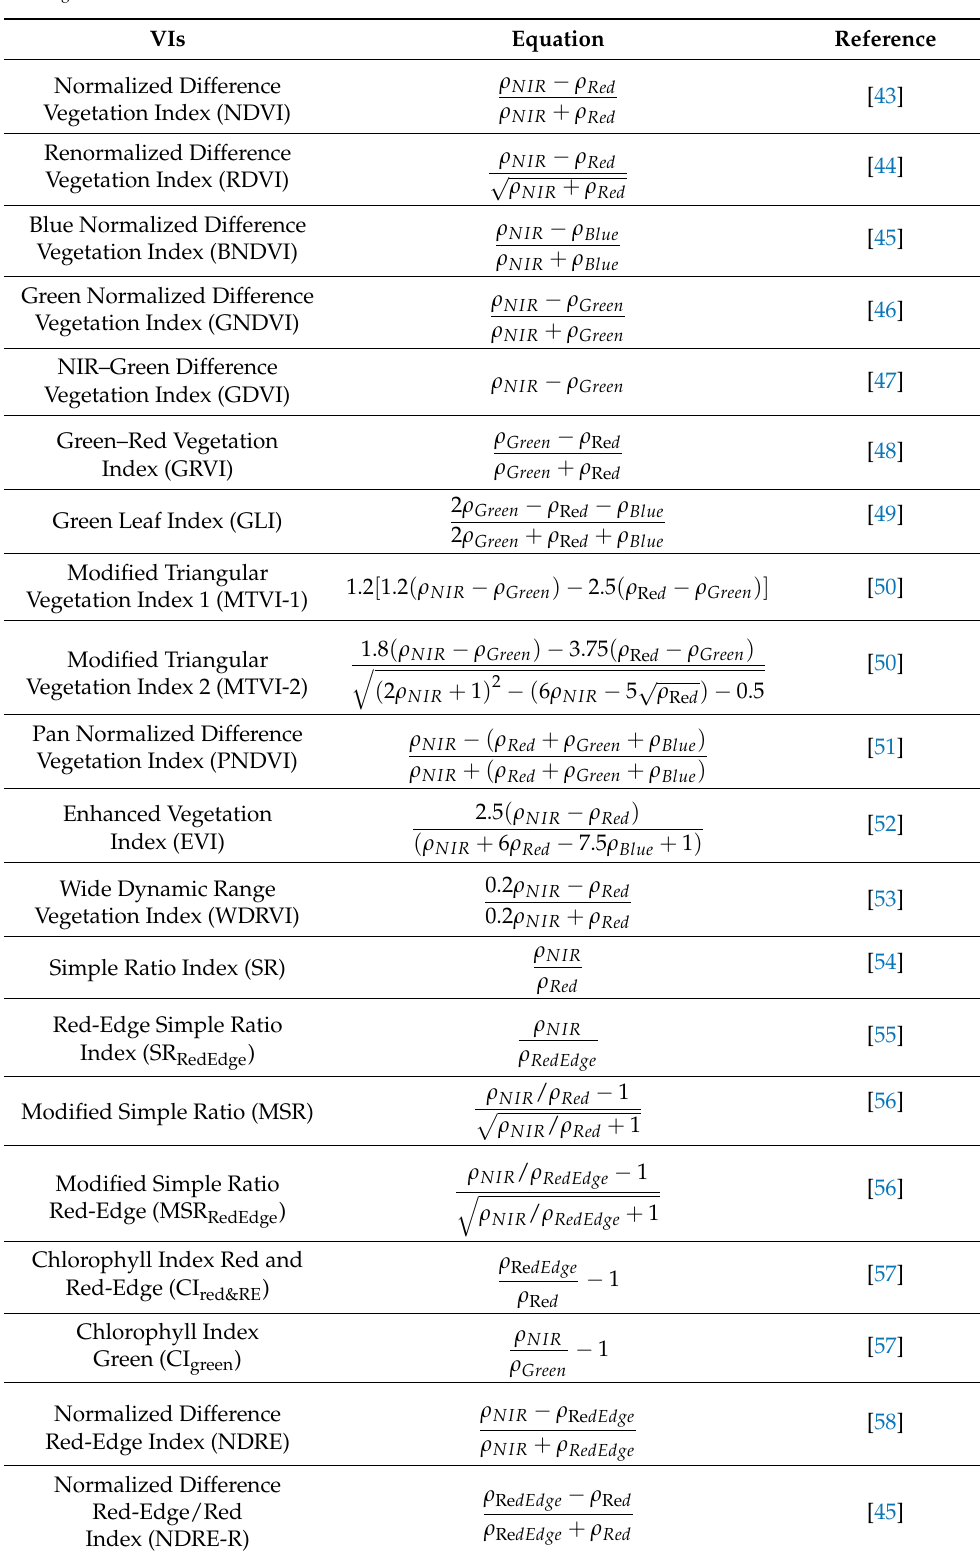
Table 2. Vegetation indices (VIs) selected for the biomass estimation. ρ Red , ρ Green , ρ Blue , ρ NIR and ρ RedEdge are the reflectance values of the red, green, blue, near-infrared, and red-edge